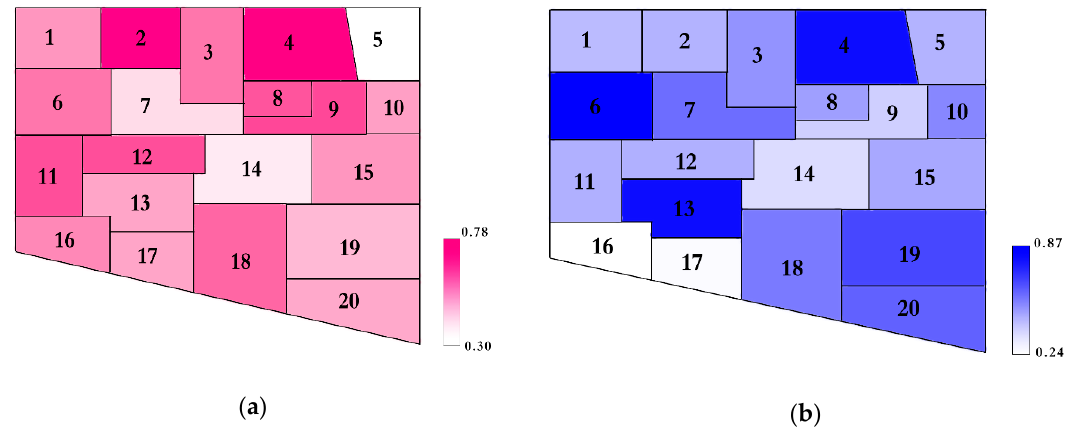
Figure 12. The comprehensive scores of individuality indexes in various regions. ( a ) The scores of WG in various regions; ( b ) The scores of EV in various regions.